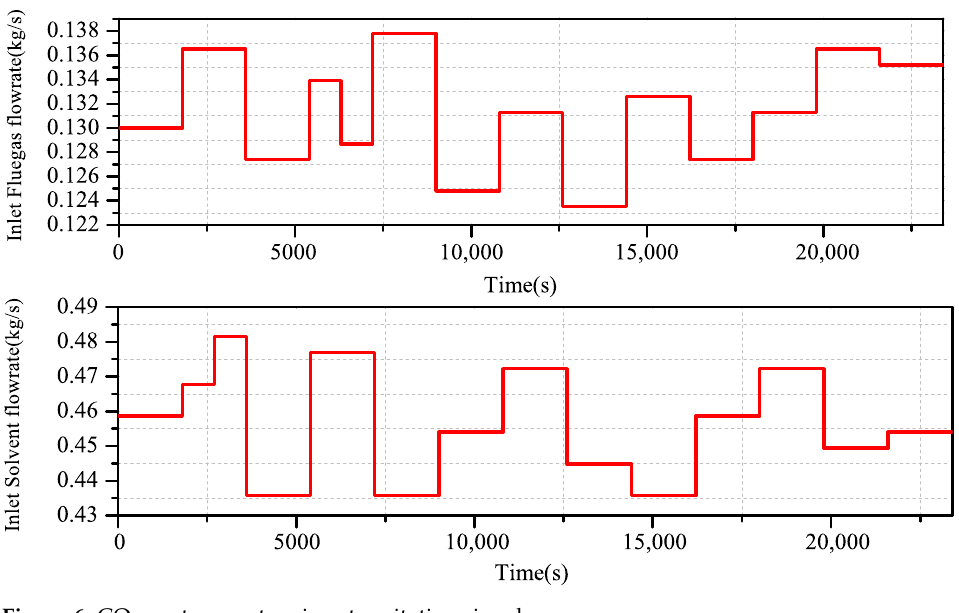
Figure 6. CO 2 capture system input excitation signal.